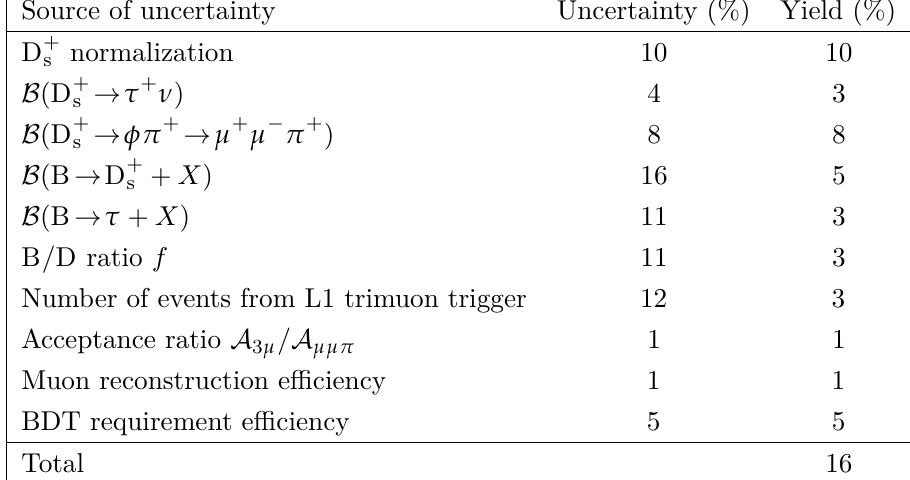
Table 2 . The sources of systematic uncertainties in the heavy-flavor analysis affecting signal modeling and their impact on the expected signal event yield. The columns labeled Uncertainty and Yield give the relative uncertainty associated with the source, and the resulting effect on the yield,